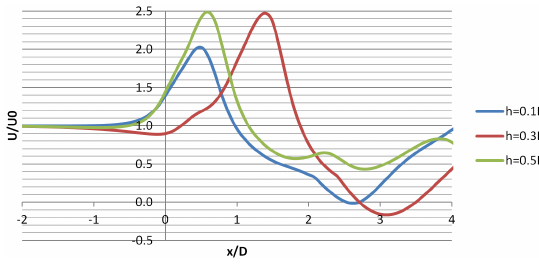
Figure 12: Streamwise flow velocity distribution for the case 2 α =22°and varying brim